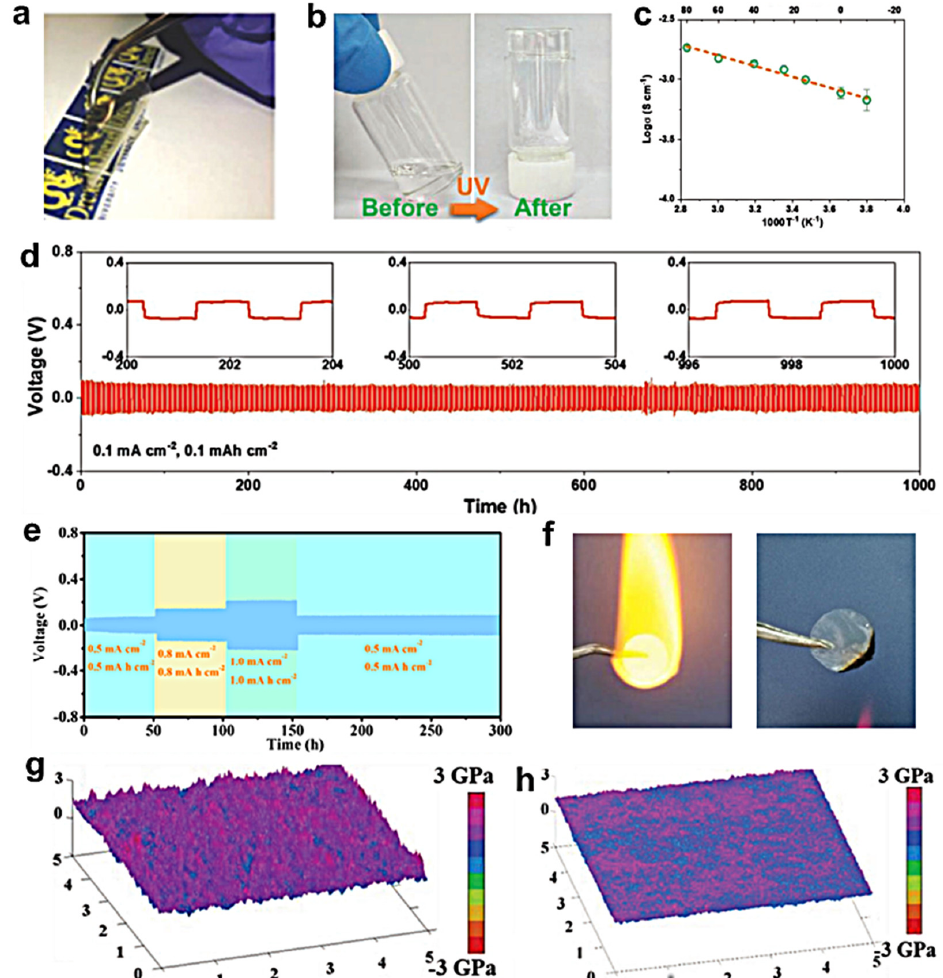
Figure 4. ( a ) Photograph of a hybrid crosslinked SPE membrane, reproduced with permission